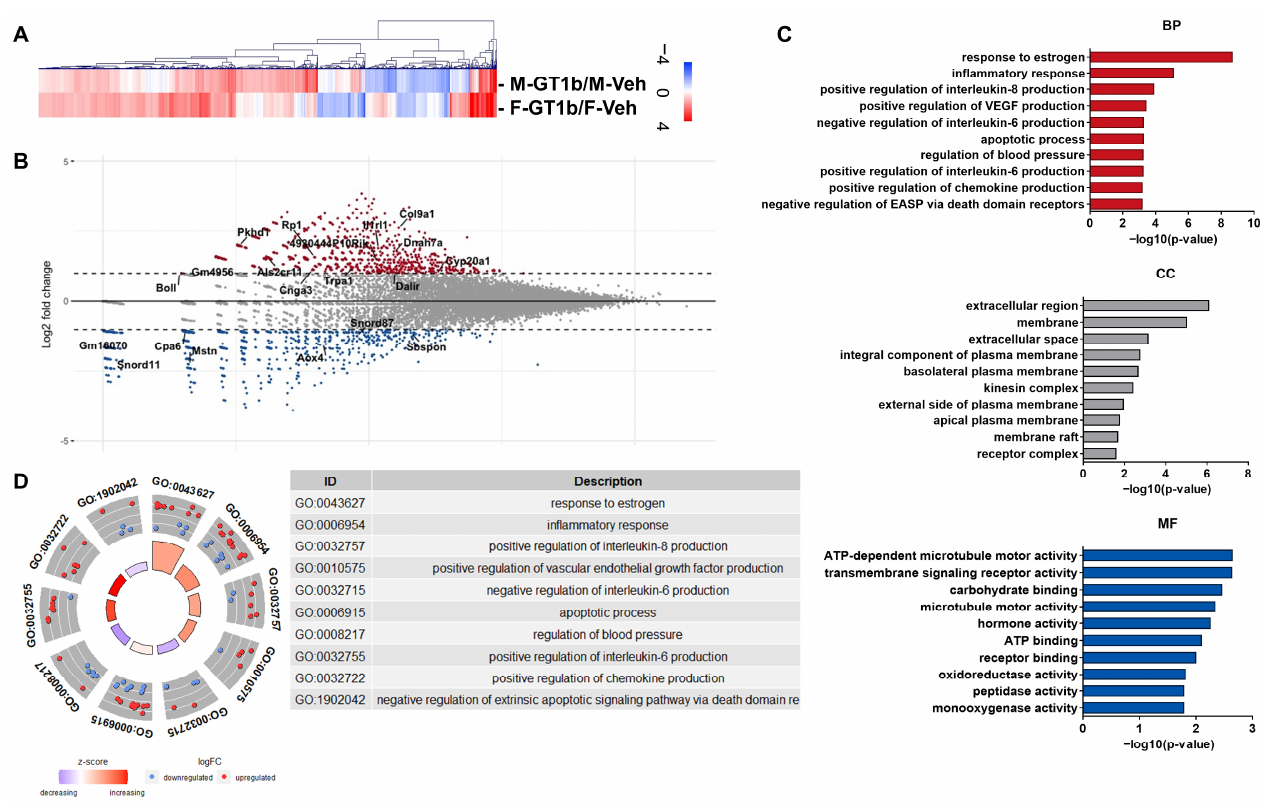
Figure 2. Transcriptomic analysis of GT1b-injected mouse spinal cords. ( A ) Heat map of RNASeq transcriptome analysis for 23281 genes after 24h of i.t. injection of GT1b ( B ) MA plot for DEGs of GT1b-stimulated female compared to GT1b-stimulated male mice. Greater than two-fold upregulated or downregulated genes are plotted. Y-axis shows the fold induction of DEGs, and the X-axis shows the basal expression level of each gene. ( C ) The top ten enriched GOs were analyzed using DAVID functional gene ontology analysis of DEGs (BP: Biological process, CC: cellular component, and MF: molecular function). ( D ) GOcircle plot displaying the fold change (logFC) of each gene in the top ten enriched BP GO terms. The chart displays the annotation categories of each GO. Z-scores are displayed in the inner circles. M-GT1b: GT1b administered male. M-Veh: vehicle administered